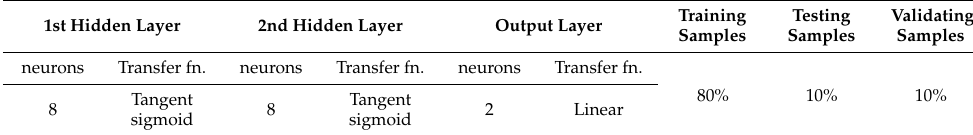
Table 3. The architecture of